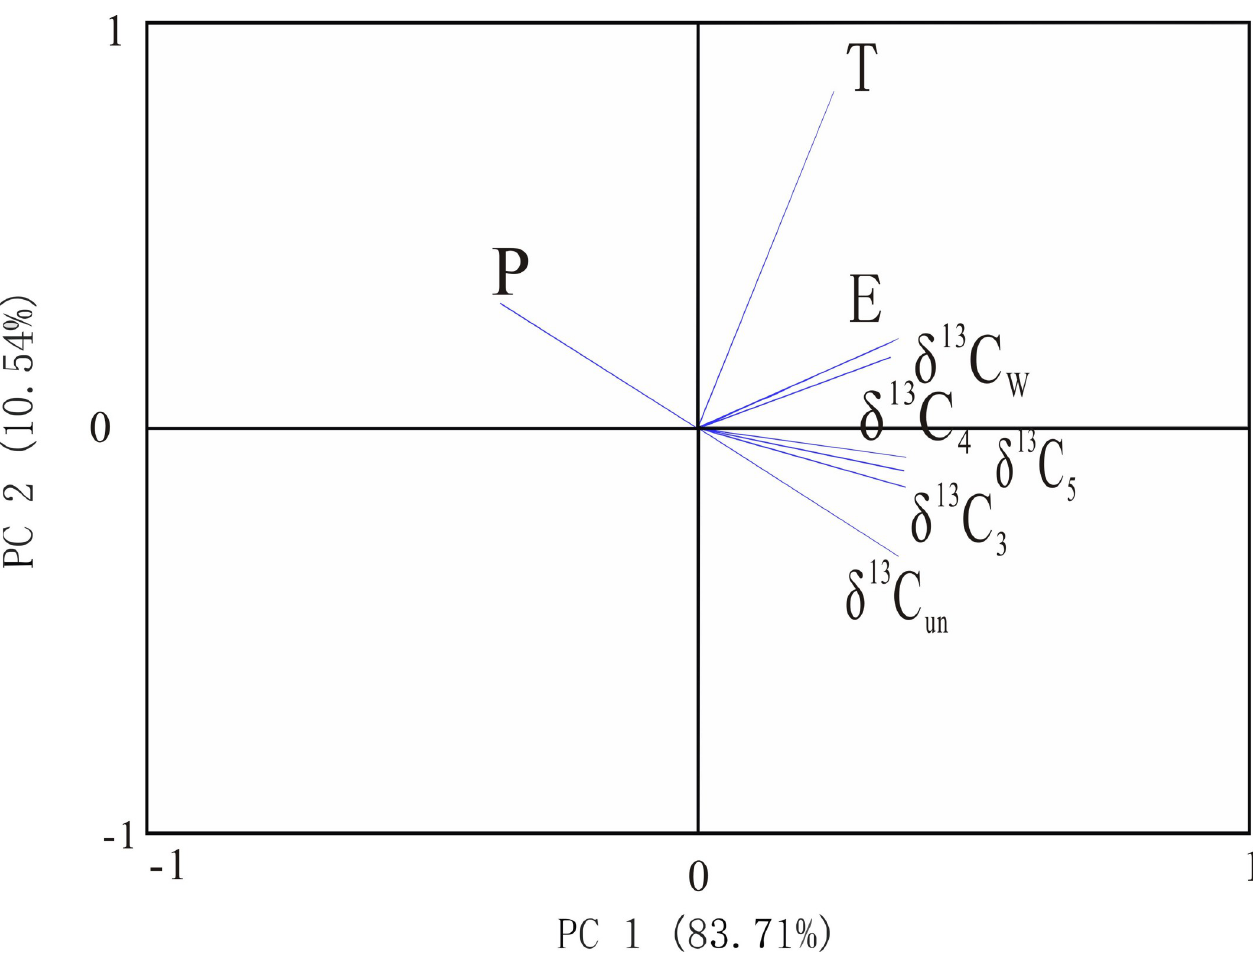
Fig 4. Component weights plot of the principal components analysis ( Pinus ). (P is precipitation; T is temperature; E is evaporation; δ 13 C un (without carbonization); δ 13 C 3 (300˚C carbonization condition), δ 13 C 4 (400˚C carbonization condition), δ 13 C 5 (500˚C carbonization condition), and δ 13 C w (wildfire carbonization